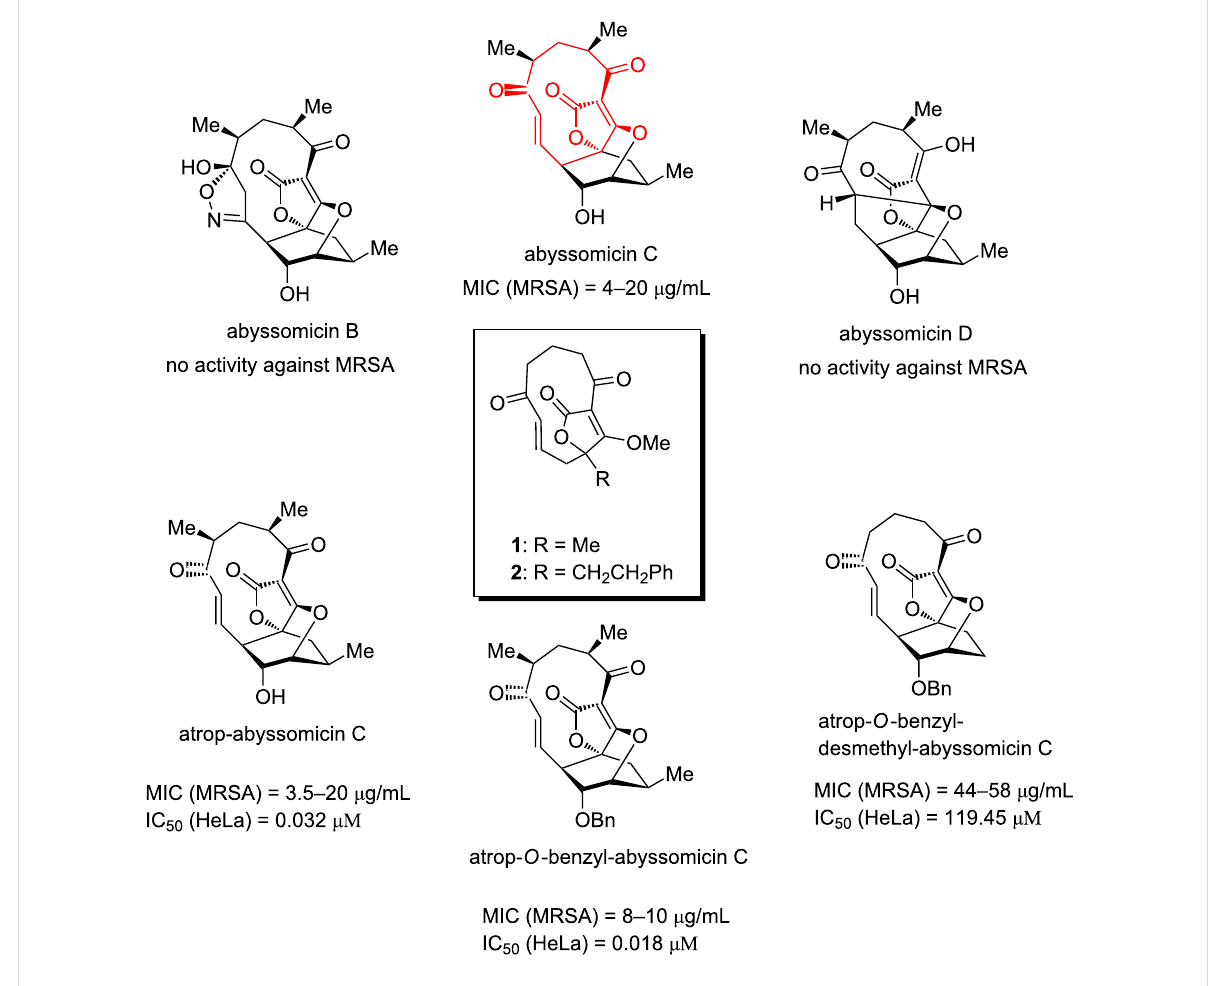
Figure 1: Structure of abyssomicins C, B, D, atrop-abyssomicin C, atrop- O -benzyl-abyssomicin C and atrop- O -benzyl-desmethyl-abyssomicin C with their biological activities, and the truncated derivatives 1 and 2 . In red: part of abyssomicin C that is maintained in the truncated derivatives